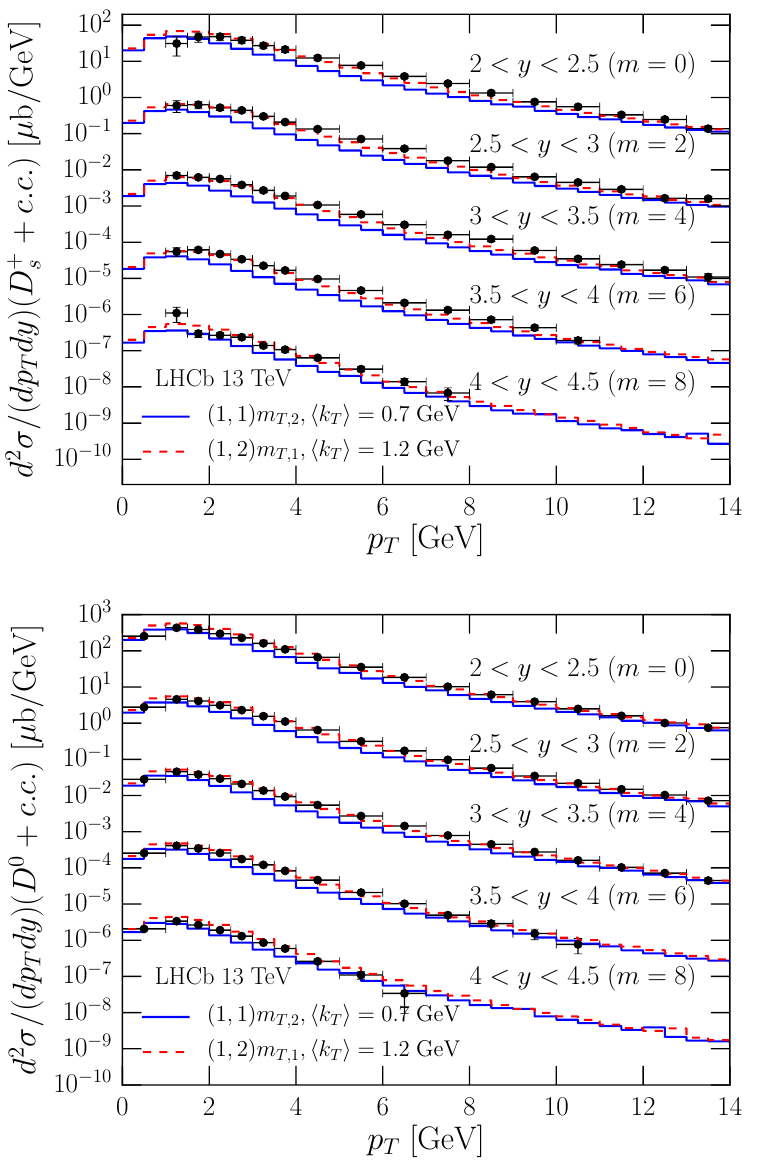
Figure 6. The double-differential distribution d 2 σ/dp T dy for D + √ (lower) production at s = 13 TeV [20], with input ( µ R , µ F ) = (1 , 1) m T, 2 and h k T i = 0 . 7 GeV (solid) and ( µ R , µ F ) = (1 , 2) m T and h k T i = 1 . 2 GeV (dashed), compared with LHCb data. The distributions are scaled as in figure